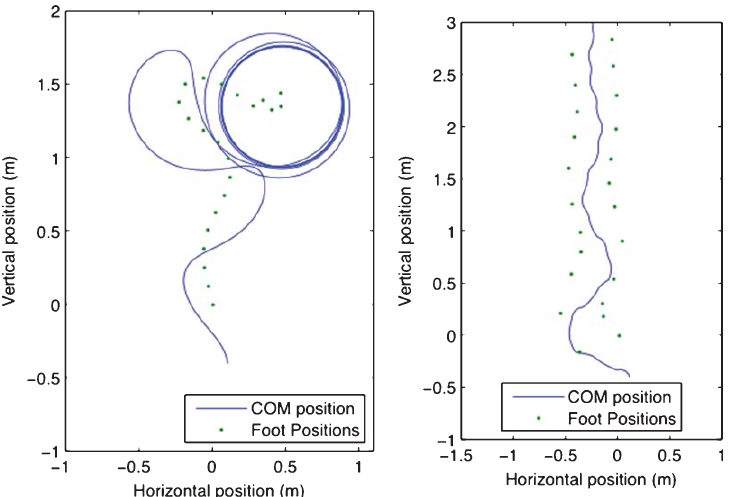
Fig. 6. The body-switched motor-powered climber’s point mass traced along the Y – Z plane as it climbs. Green dots show the attachment points used by the climber. The sprawl angle of the left climber is (cid:1) =0 ◦ and for the right it is (cid:1) =25 ◦ . The climbers began with a slight lateral perturbation, yet evidently the non-sprawled climber becomes unstable, while the sprawled climber converges to a singly periodic gait.